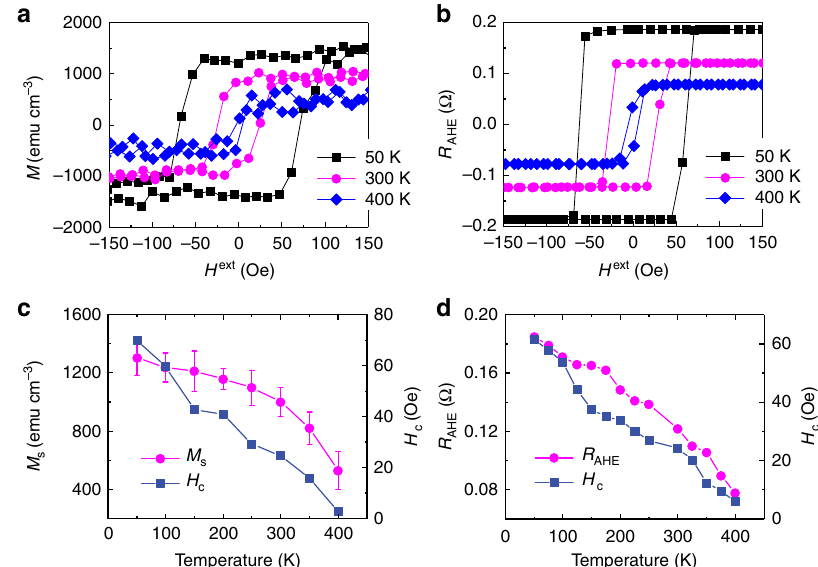
Fig. 2 Temperature-dependent magnetic properties. a Magnetization ( M ) and b R AHE as a function of H ext for Pt/Co/SiO 2 /Pt heterostructures with H ext perpendicular to the fi lm plane and measurement temperature of 50, 300, and 400 K. c , d Temperature dependence of M s , R AHE , and H c . The error bars in c are de fi ned as s.d. The H c in ( c ) is obtained from M – H ext curve and that in ( d ) is extracted from R AHE – H ext